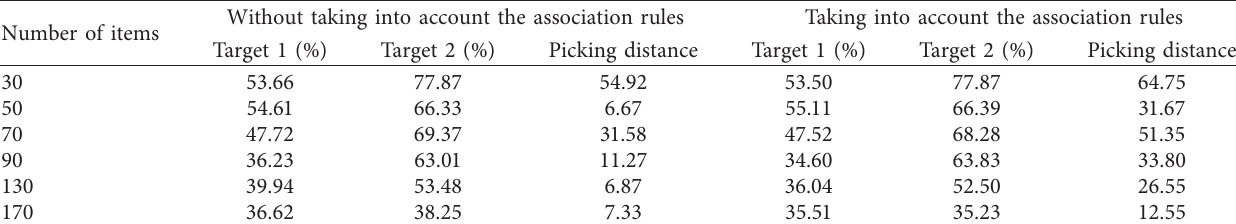
Table 6: The optimization percentage for each target.